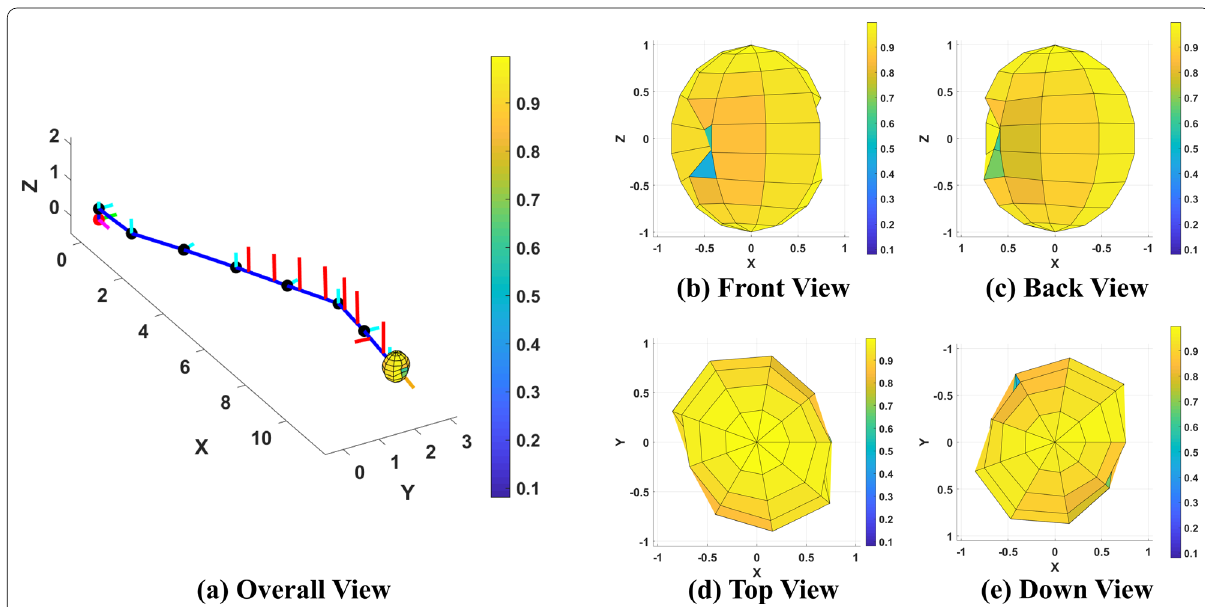
Fig. 6 a Overall view of the human-experience-based flying watch allocation, end effector reaction force, and the corresponding average TDS in the static object holding mission. b Front view of TDS. c Back view of TDS. d Top view of TDS. e Bottom view of